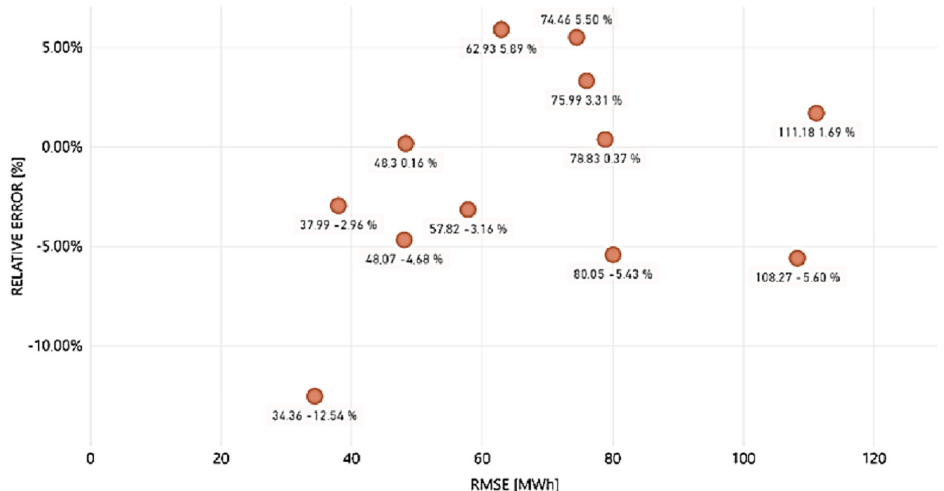
Figure 12. RMSE of monthly aggregate net energy.